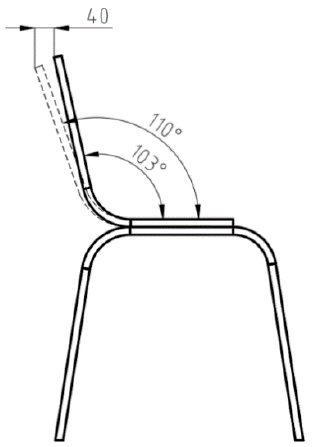
Figure 4. Deformation of the flexible chair.